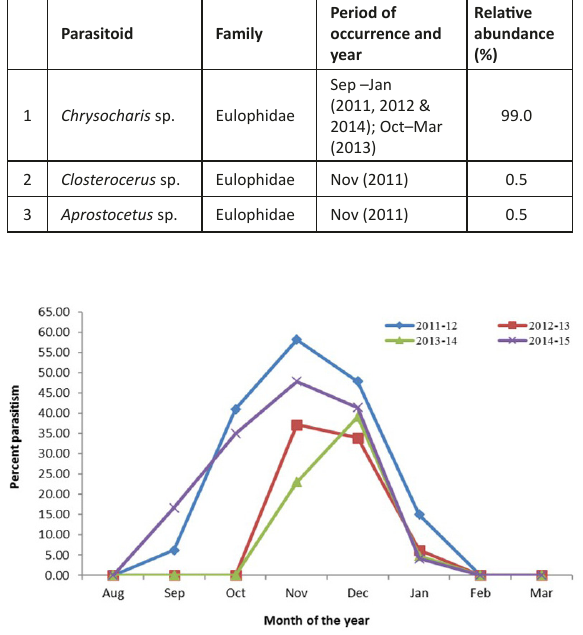
Figure 1. Percentage of parasitism of leaf miner larvae by Chrysocharis sp. from 2011 to